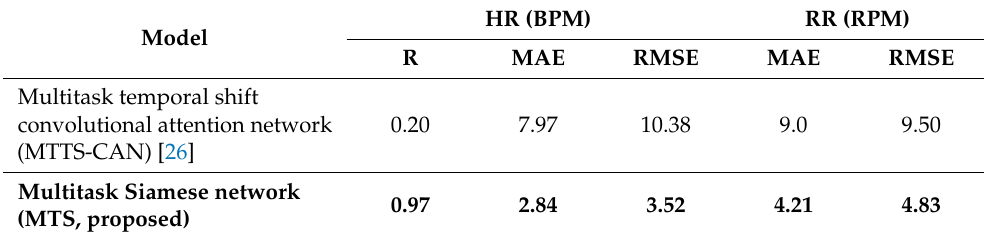
Table 2. Benchmark test results comparing multitask Siamese network model (MTS) with other multitask models. Heart rates (HR) and respiration rates (RR) are calculated in beats per minute (BPM) and respiration per minute (RPM), and the model performances are evaluated using the metrics of Pearson correlation coefficient (R), mean average error (MAE), and root-mean-squared error